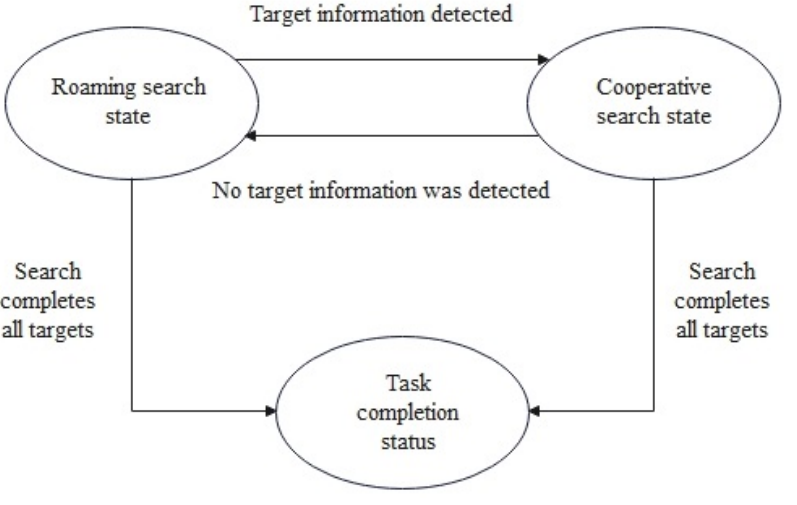
Figure 1. Three robot states relationship.